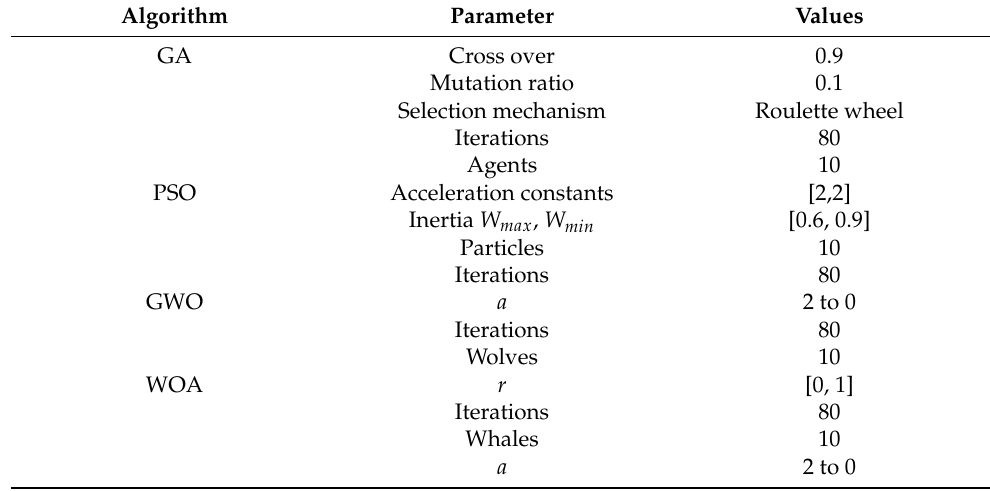
Table 2. Configuration parameters of the competing optimization